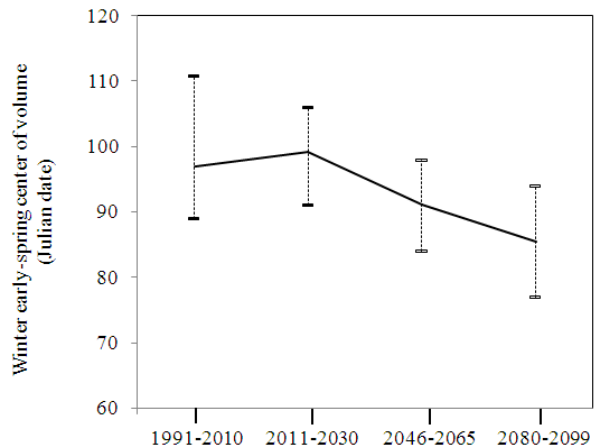
Fig. 10. Shift in river discharge timing in the future compared to Fig. 10 Shift in river discharge timing in the future compared to baseline climate conditions. baseline climate conditions. The whiskers represent the interquar- The whiskers represent the interquartile range for the 25 th and 75 th percentiles from all 10 tile range for the 25th and 75th percentiles from all 10 scenarios. scenarios. The solid line represents the average of 10 scenarios. The solid line represents the average of 10